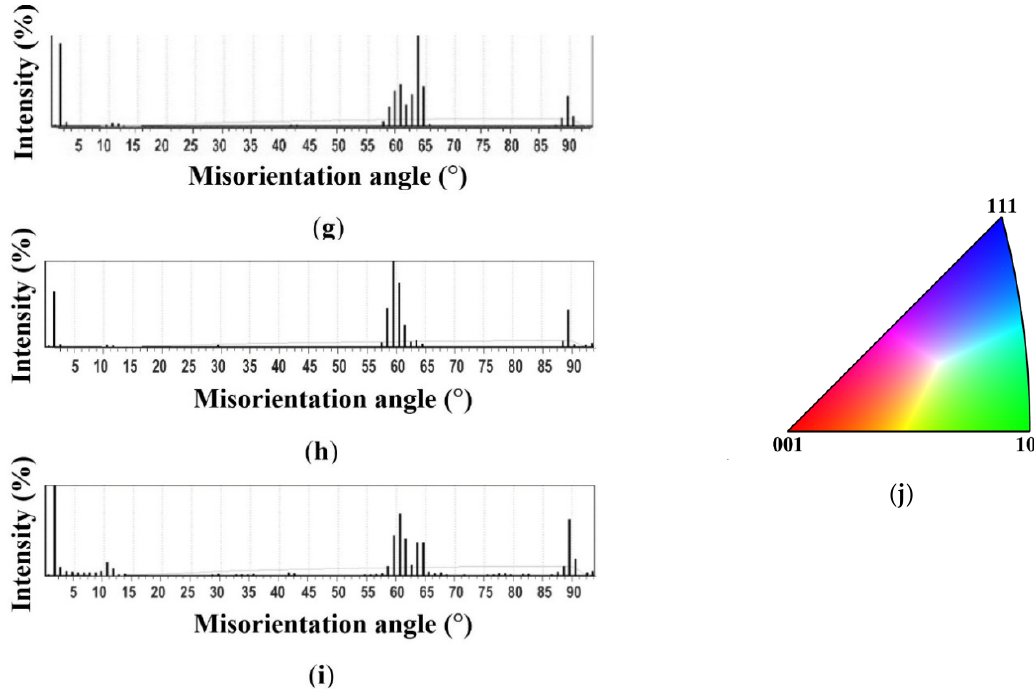
Figure 2. The orientation maps for the samples depending on the cooling rate in the form of orientation maps: ( a ) WQ, ( c ) AC, ( e ) FC; the orientation maps of the reconstructed high-temperature β -grain: ( b ) WQ, ( d ) AC, ( f ) FC; the misorientation angle distribution in the α -phase for WQ, AC, FQ: ( g ) WQ, ( h ) AC, ( i ) FC; ( j ) IPF color key.